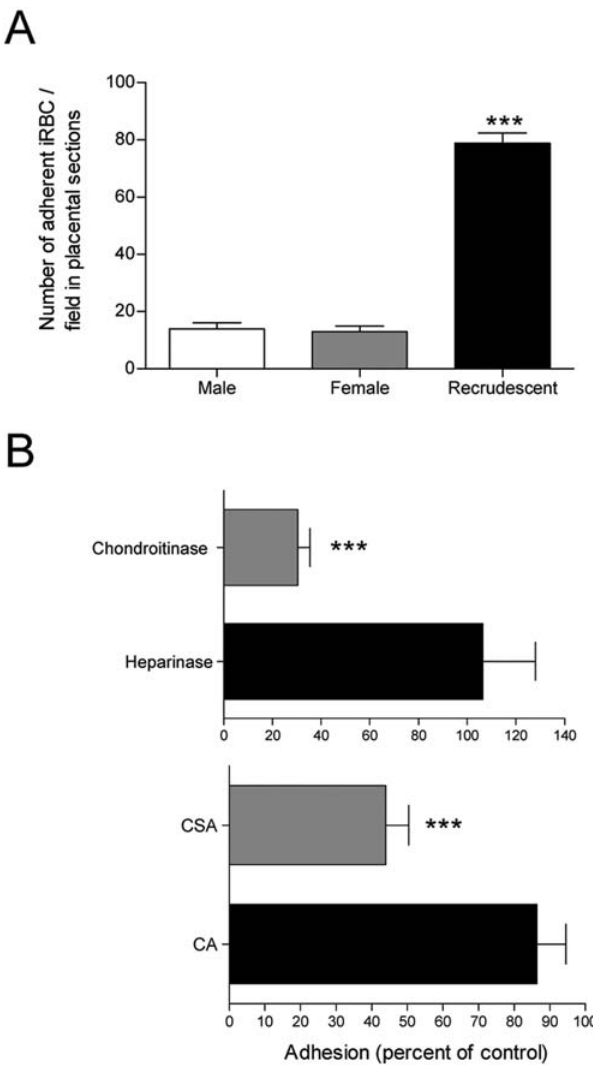
Figure 4. P. berghei iRBC from recrudescent females show enhanced adhesion to placenta. iRBC from males, non-pregnant females and recrudescent primiparous females were incubated on uninfected placental sections and the adherent parasitized cells were counted as described in Materials and Methods section (A). Adhesion assays were also performed after pre-treatment of placental sections with chondroitinase ABC or heparinase (negative control) (B, upper plot). Adhesion inhibition assays were carried out by pre-incubating iRBC from recrudescent females with 1 mg/ml concentrations of CSA or CA (negative control) (B, lower plot). In panel B the proportion of bound iRBC is expressed as a percentage of the control (non-treated placentas or non-preincubated iRBC, in upper and lower plots, respectively). Error bars represent the mean 6 s.e.m. of three independent experiments. (***, P -value , 0.001).